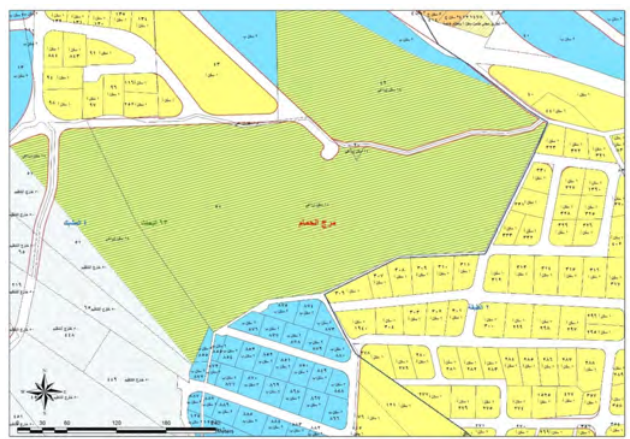
Figure 11. Discontinued quarry site land use map. Source: GAM- GIS for the author (2016).